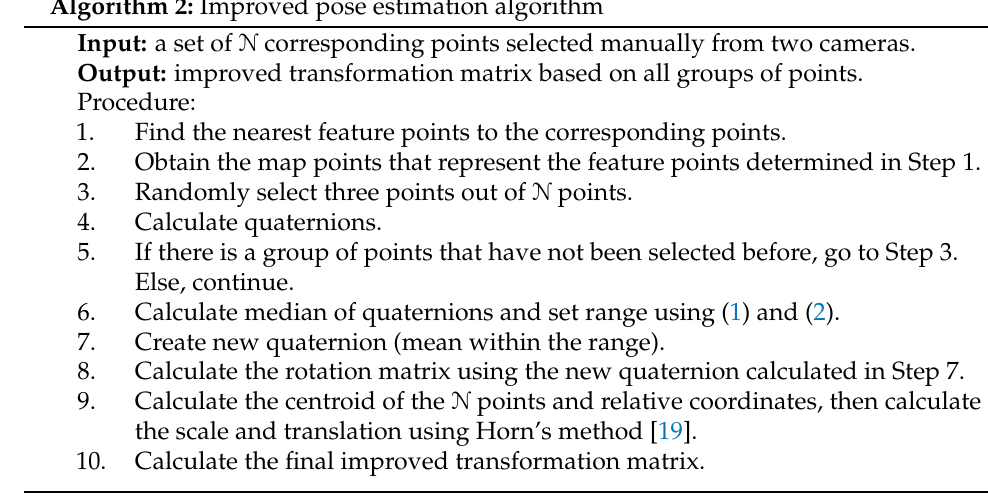
Algorithm 2: Improved pose estimation